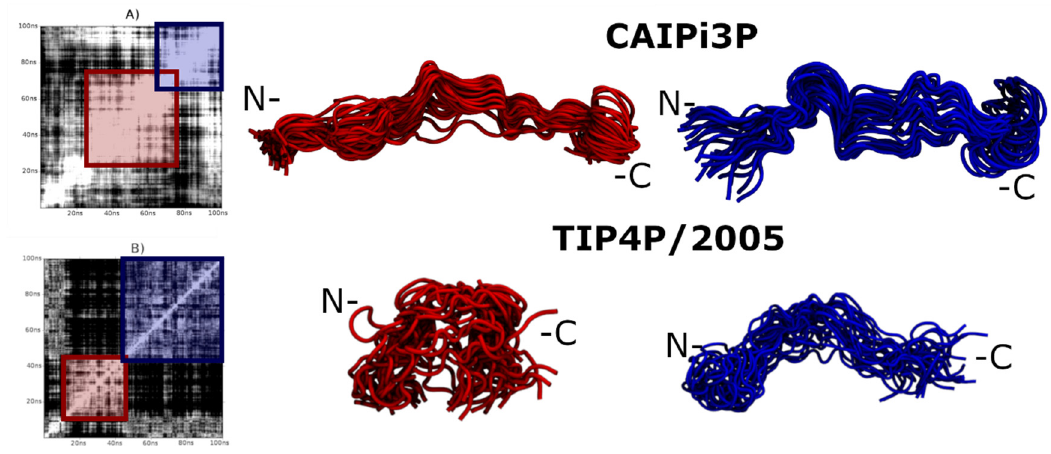
Figure 2. RMSD matrices and their respective clusters obtained by AMBER03ws. ( A ) CAIPi3P matrix.